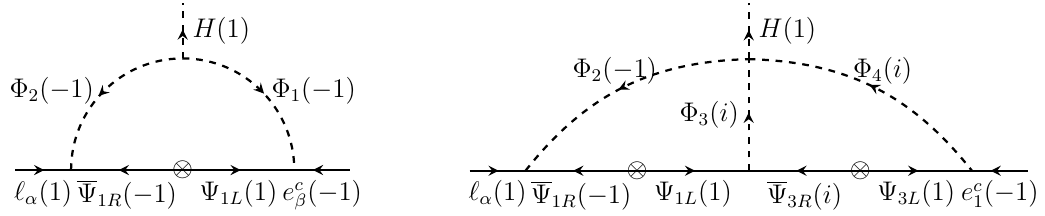
Figure 3 . One- and two-loop Feynman diagrams contributing to the entries of the SM charged lepton mass matrix. Here, (cid:11) = 1 ; 2 ; 3 and (cid:12) = 2 ; 3. Z 4 charges are given explicitly in brackets and the softly breaking terms are denoted by . (cid:10)